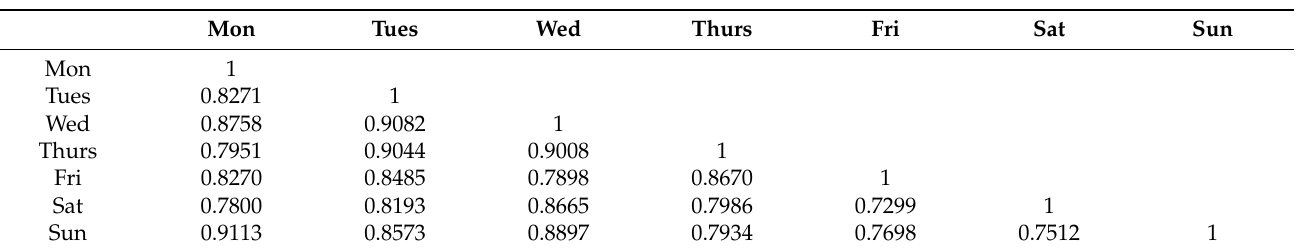
Table 4. Values of winter day type similarity.